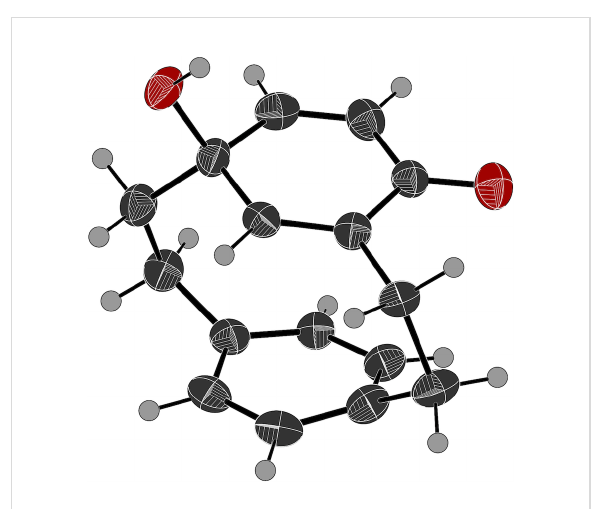
Figure 5: Crystal structure of 15 . Ellipsoids are drawn at a 50% proba- bility level [63].